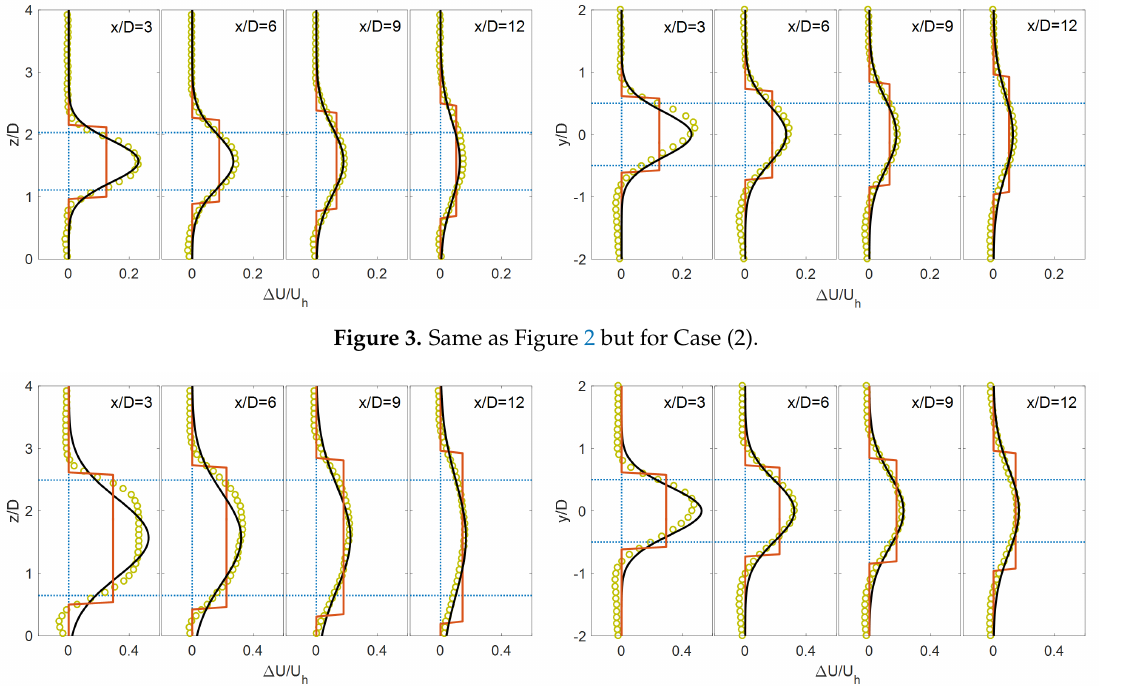
Figure 4. Same as Figure 2 but for Case (3).